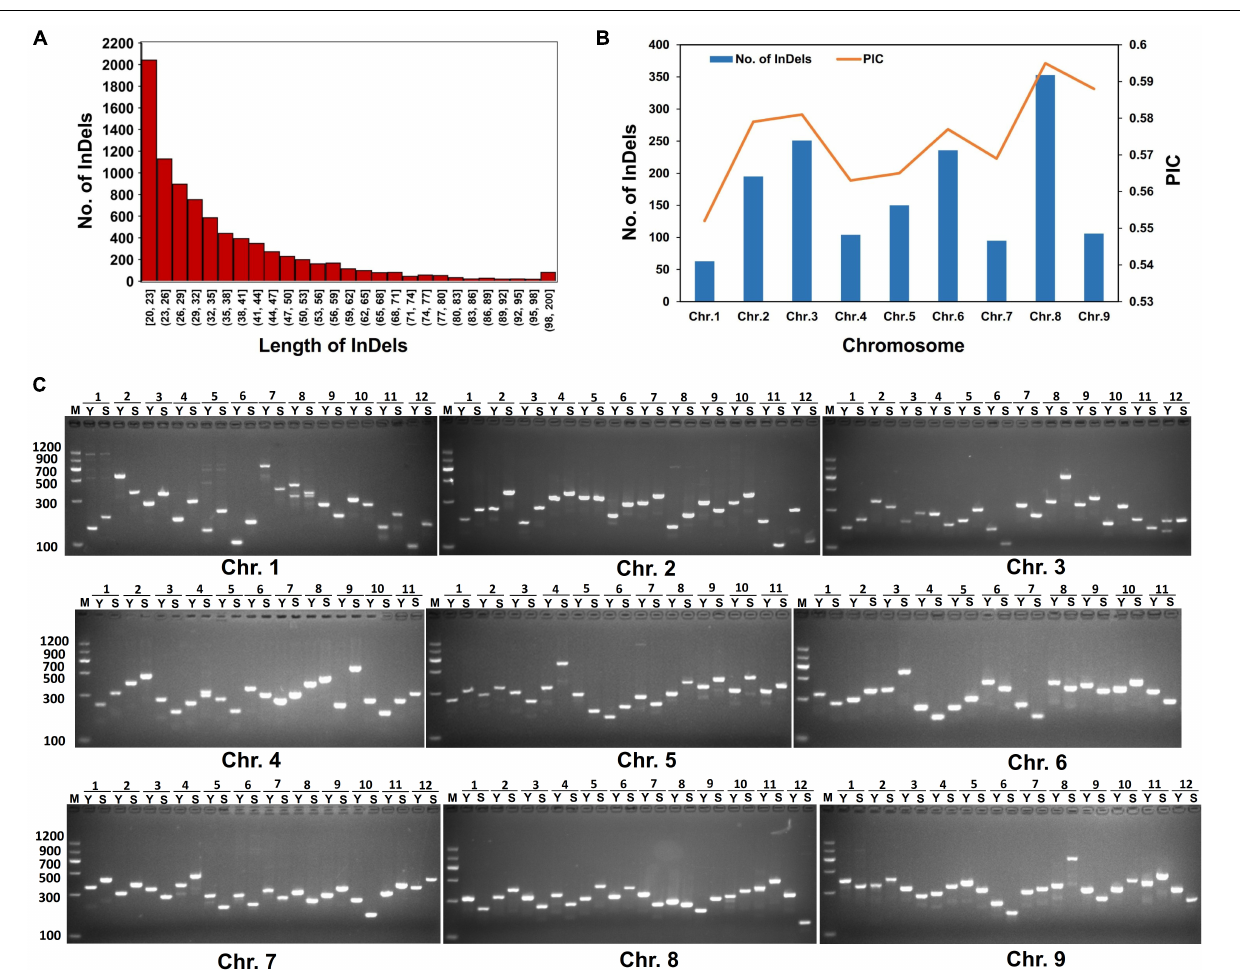
FIGURE 4 | Characterization of polymorphic molecular markers. (A) Length distribution of InDel markers. (B) Polymorphism information content (PIC) variations of polymorphic molecular markers among different chromosomes. (C) Agarose gel electrophoresis analysis of PCR products amplified using representative